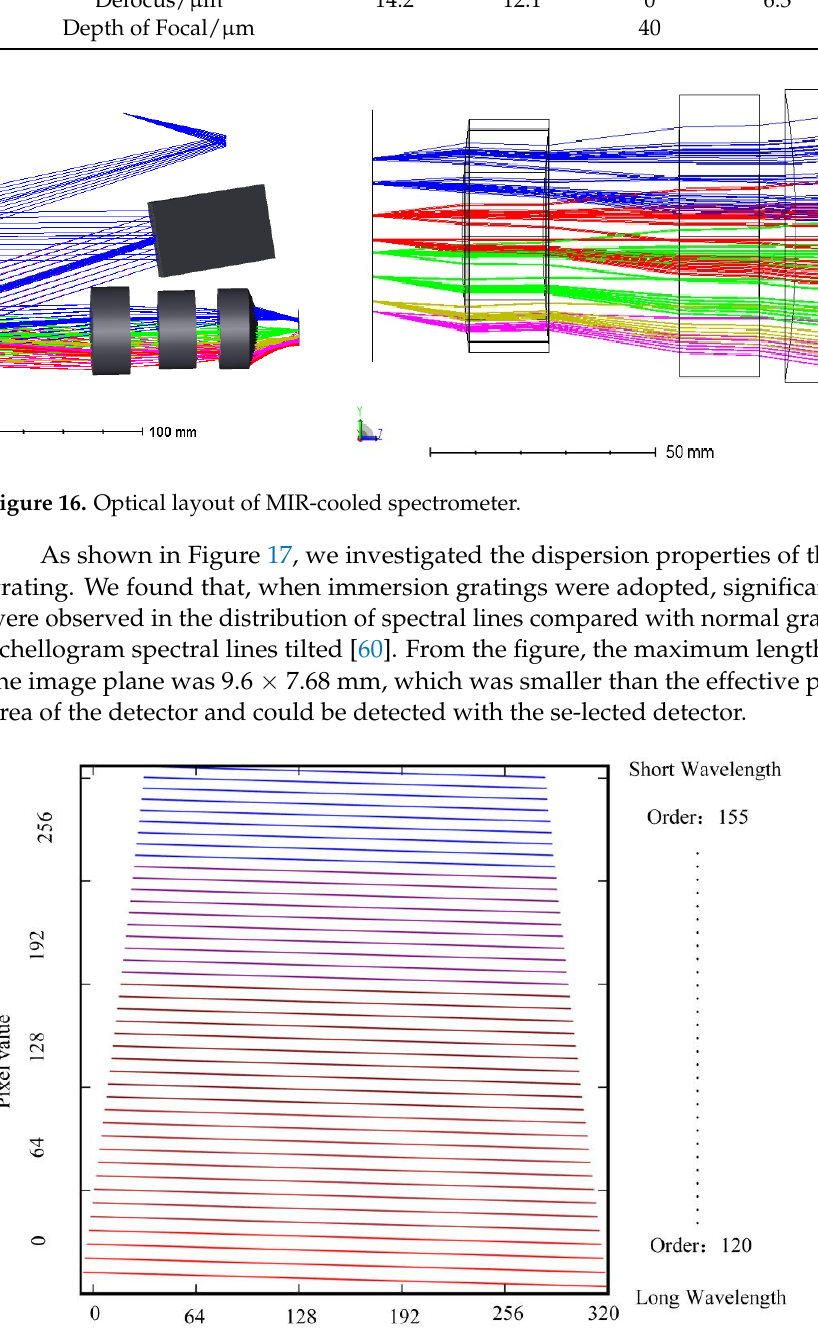
Figure 16. Plots of MTF curves of optical system at different temperatures: ( a ) 20 ° C; ( b ) − 50 ° C; ( c ) 50 ° C.